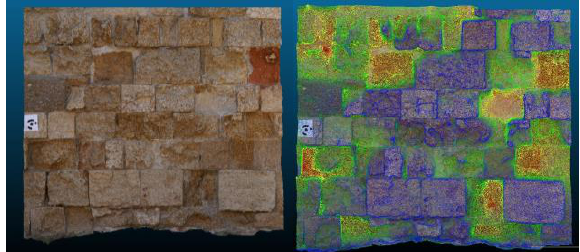
Figure 13. The 3D Textured Model (left) and the visualization of the scalar field on the 3D Textured Model (right).